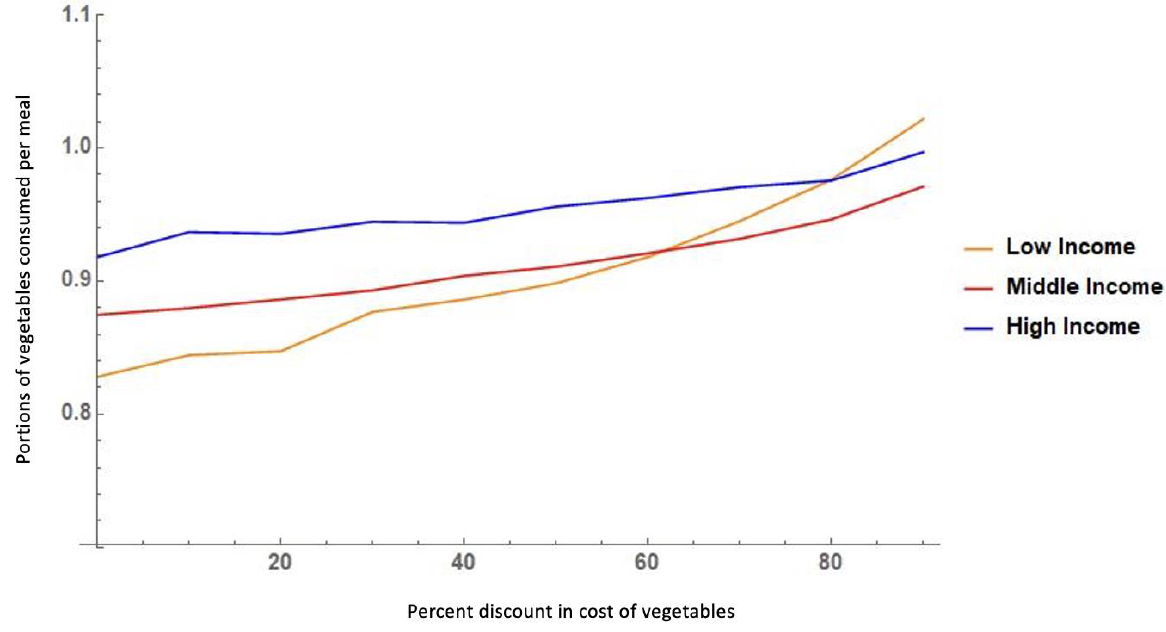
Figure 3. Agent-based model simulated response to discounts in the cost of vegetables by income level.